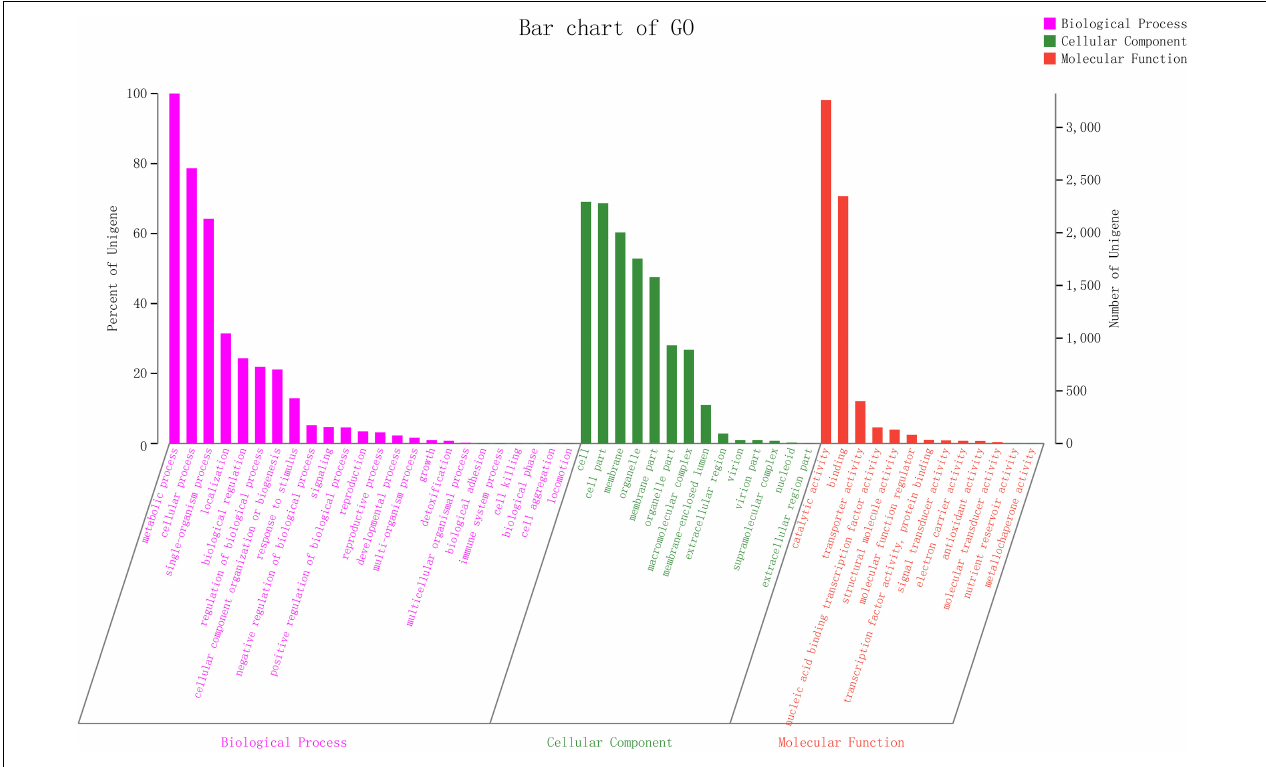
FIGURE 4 | Gene ontology (GO) slim classifications for the